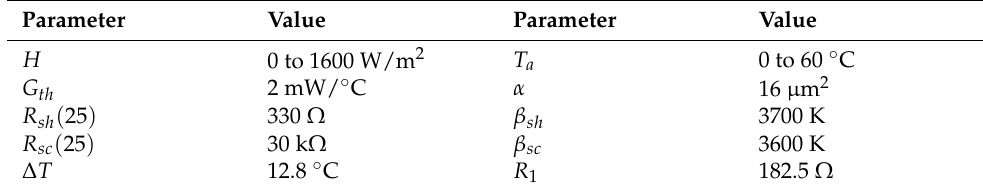
Table 3. CTD parameters used in simulation.